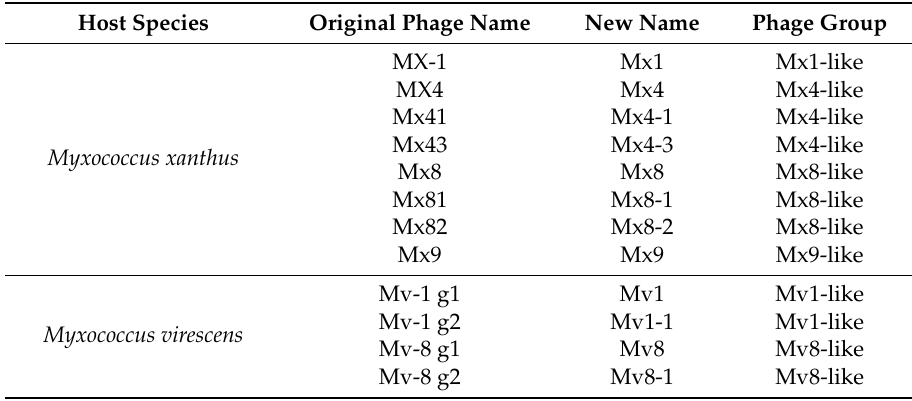
Table 3. Applying proposed nomenclature to previously isolated